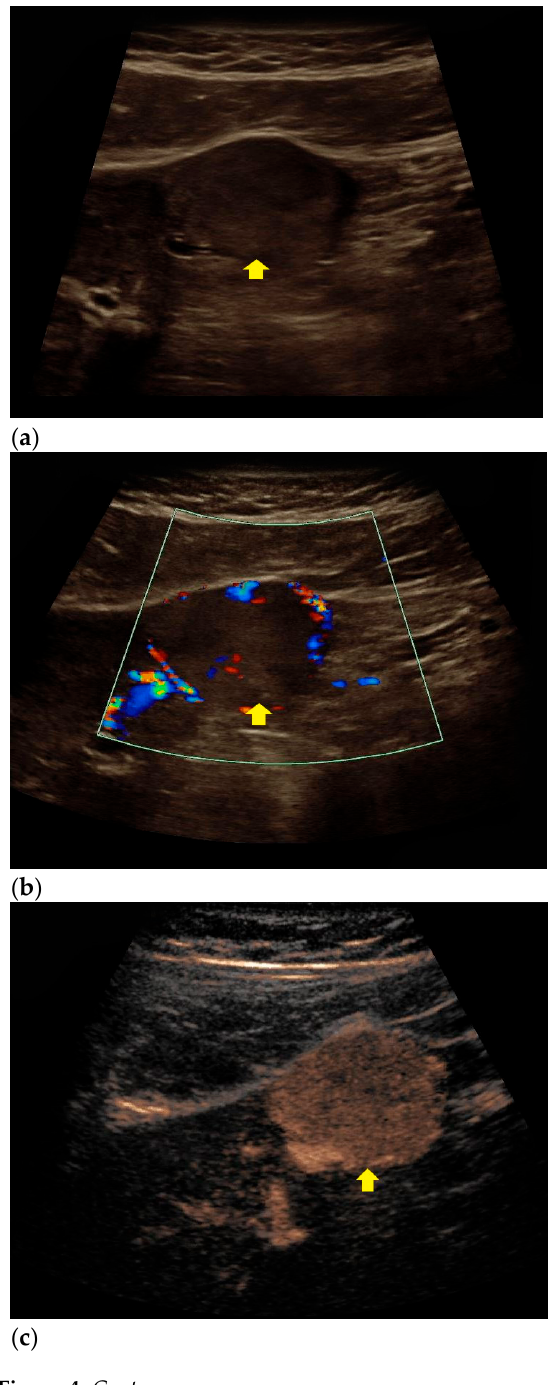
Figure 3. Sonomorphological features and histopathological assessment of poorly differentiated hepatocellular carcinoma (HCC). ( a ) Homogeneous, hyperechoic liver lesion in native B-mode (yellow arrow). ( b ) The lesion shows peripheral hypervascularization in Doppler mode (yellow arrow). ( c ) In CEUS, peripheral rim contrast enhancement was detected in the arterial phase (yel- low arrow). ( d ) In the late venous phase, the lesion showed typical rapid wash-out (yellow arrow), peripheral rim contrast enhancement was detected in the arterial phase (yellow arrow). ( d ) In the thus indicating HCC. ( e ) Hematoxylin and Eosin staining of the suspicious lesion, 20× magnifica- late venous phase, the lesion showed typical rapid wash-out (yellow arrow), thus indicating HCC. tion. Poorly differentiated hepatocellular carcinoma with concomitant necrosis (black star) and ( e ) Hematoxylin and Eosin staining of the suspicious lesion, 20 × magnification. Poorly differentiated fibrous septa (black arrow) is hepatocellular carcinoma with concomitant necrosis (black star) and fibrous septa (black arrow) is shown.